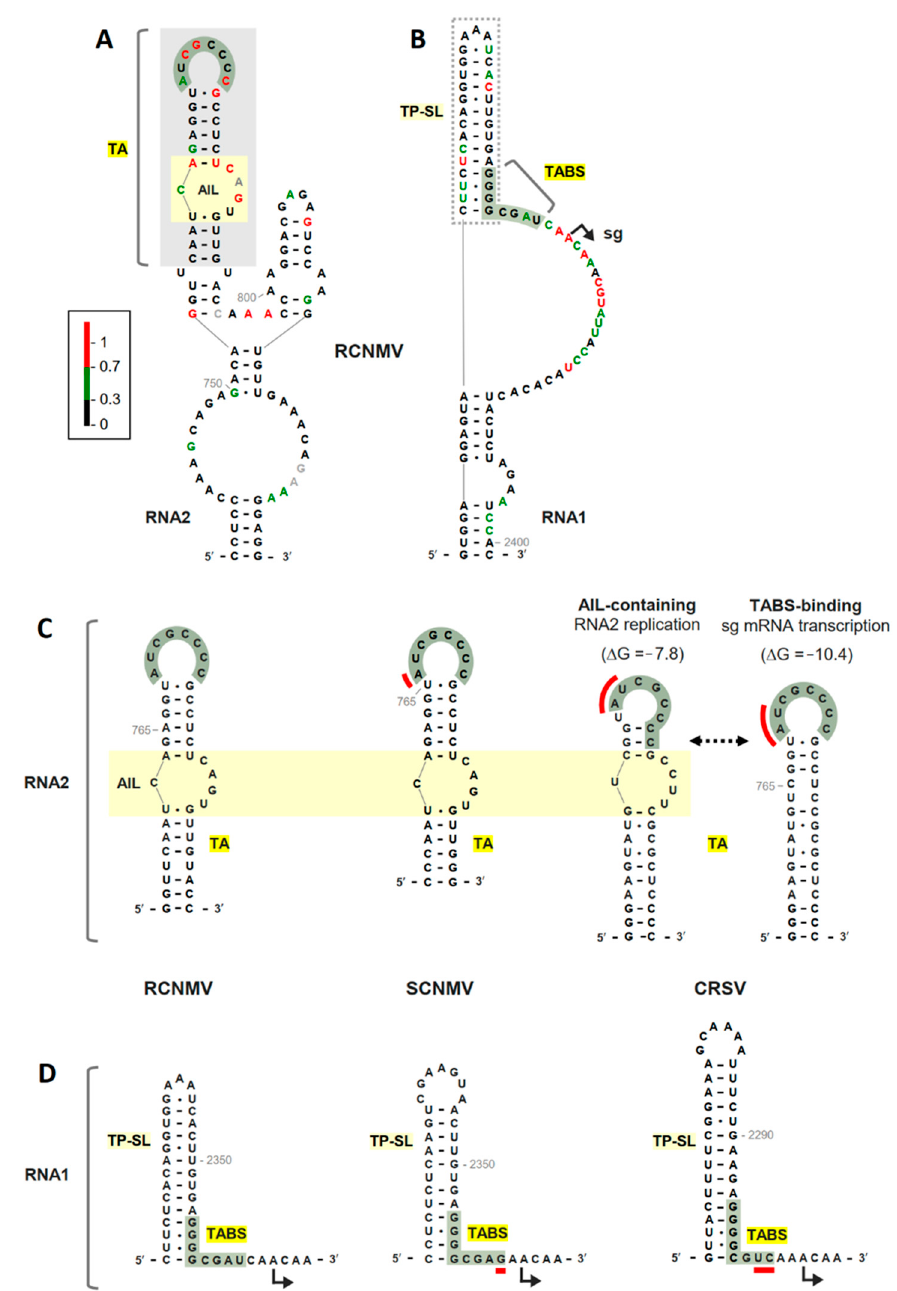
Figure 2. RNA secondary structure models of the TA and TABS in dianthoviruses. ( A ) SHAPE-guided model of TA-containing region of RCNMV RNA2. The TA and AIL structures are denoted by grey and yellow shaded boxes, respectively. The green shading depicts the terminal loop of the TA that is complementary to the TABS. Relative reactivity of nucleotides are depicted as red, green, or black bases, indicating high, moderate, and low reactivity, respectively. Grey bases denote null reactivity values. ( B ) SHAPE-guided model of TABS-containing region of RCNMV RNA1. Relative nucleotide reactivities are as described in panel A. The TABS sequence is depicted by green shading and the TP-SL structure is shown in the dotted grey box. The position of the transcription initiation site for the subgenomic mRNA (sg) is shown as an angled arrow. ( C ) Comparative secondary structure analysis of RNA2 TA in RCNMV, SCNMV, and CRSV. The dotted arrow depicts two conformations of the CRSV TA structures with their corresponding computationally predicted free energies (kcal/mol). The red lines indicate mismatches in the TA–TABS interaction. ( D ) Comparative secondary structure analysis of the RNA1 TABS and TP-SL structures in RCNMV, SCNMV, and CRSV.